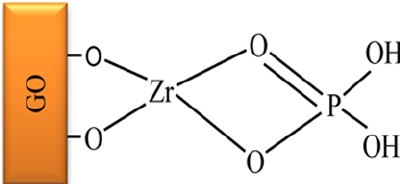
Figure 1. Schematic representation of ZrP bonded to the surface of graphene oxide (GO) ([74], with permission of ACS). permission of